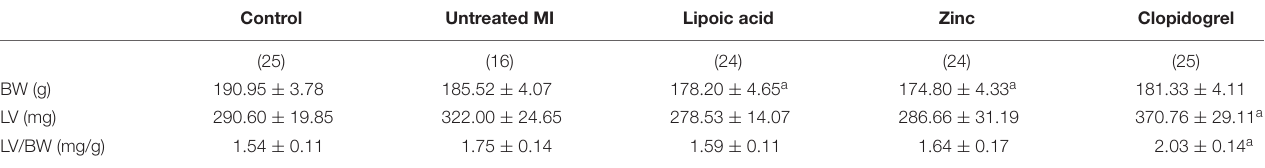
Values are represented as mean ± SEM. The number of observations is given in parentheses. MI, myocardial infarction; BW, body weight; LV, left ventricular weight; LV/BW, left ventricular body weight ratio. a Significance of differences from control group calculated by Student’s t-test for unpaired data at p < 0.05.